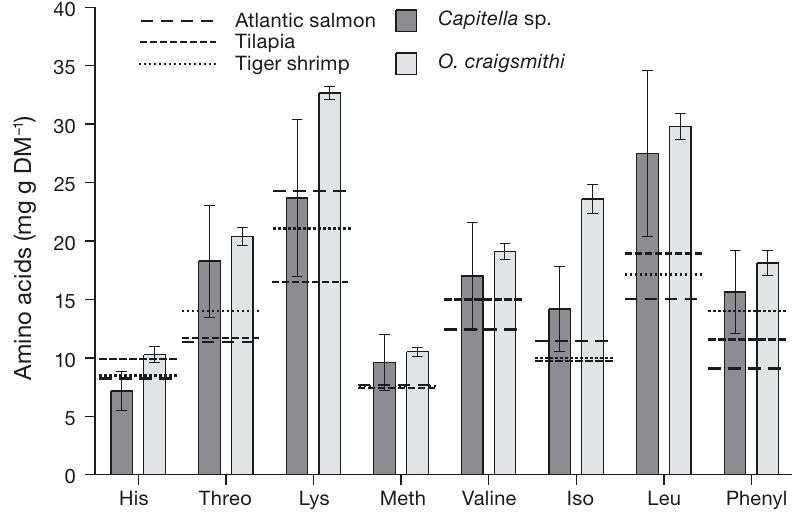
Fig. 2. Essential amino acid body compo- sition of Capitella sp. and Ophryotrocha craigsmithi measured in this study and essential amino acid requirements for Atlantic salmon, tilapia and tiger shrimp as reported in NRC (2013). Bars are mean values (n = 4 samples for Capitella sp. and 3 samples for O. craigsmithi) ; er- ror bars are SD. His: histidine; Threo: threonine; Lys: lysine; Meth: methion- ine; Iso: isoleucine; Leu: leucine; Phenyl: